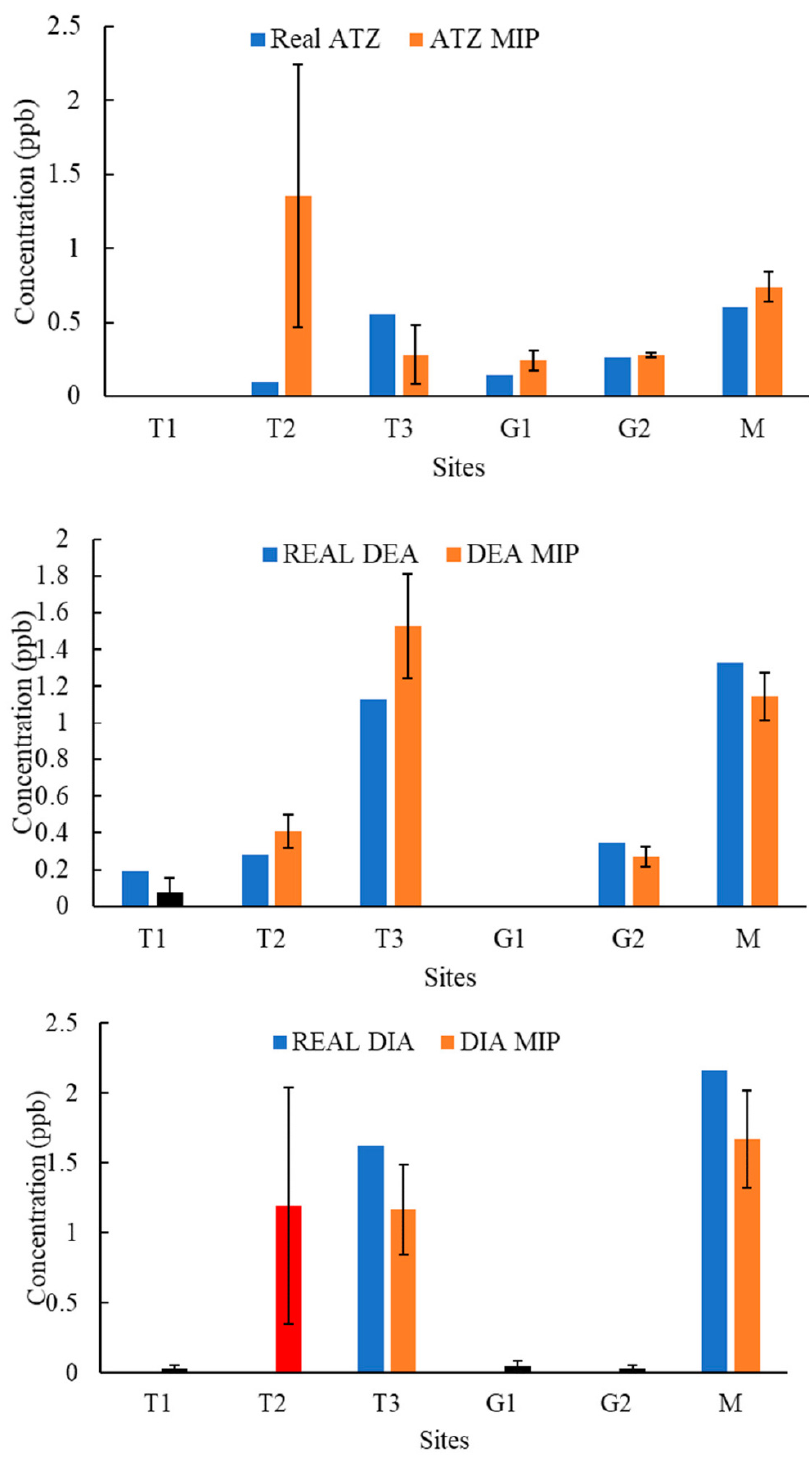
Figure 4. Average response of MIPs to ATZ, DEA, and DIA compared to real concentrations validated by LCMS/MS for samples of 12 March 2020.